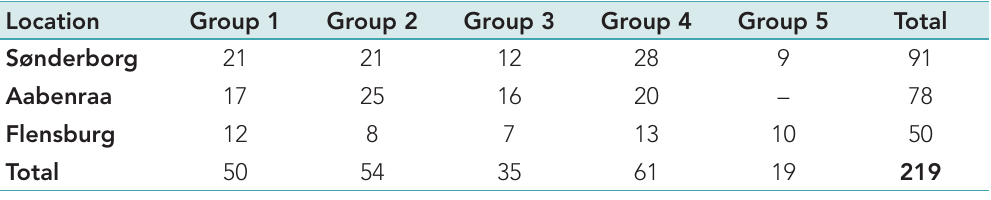
Table 2: Number of trained participants by training groups and locations